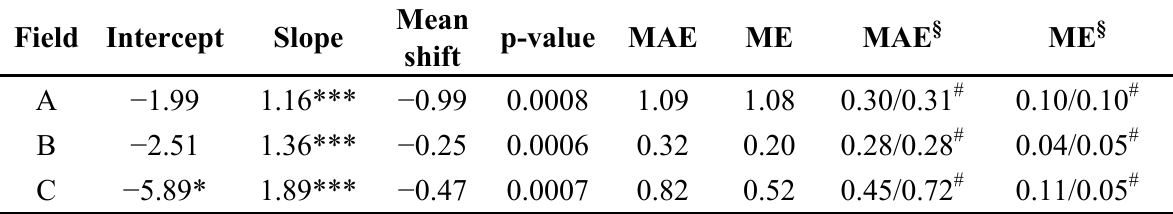
Table 3. Regression coefficients of the inverse regression between calibration pH(CaCl and on-the-go pH, mean absolute error (MAE), and mean error (ME) before and § after